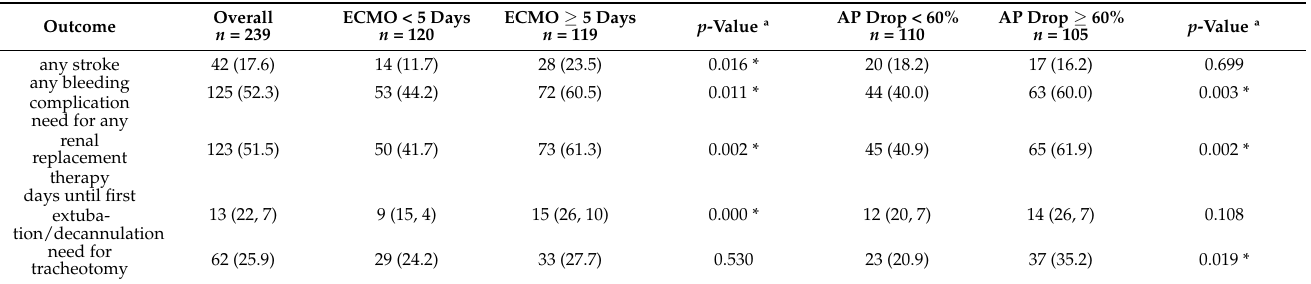
Table 3. Adverse events and